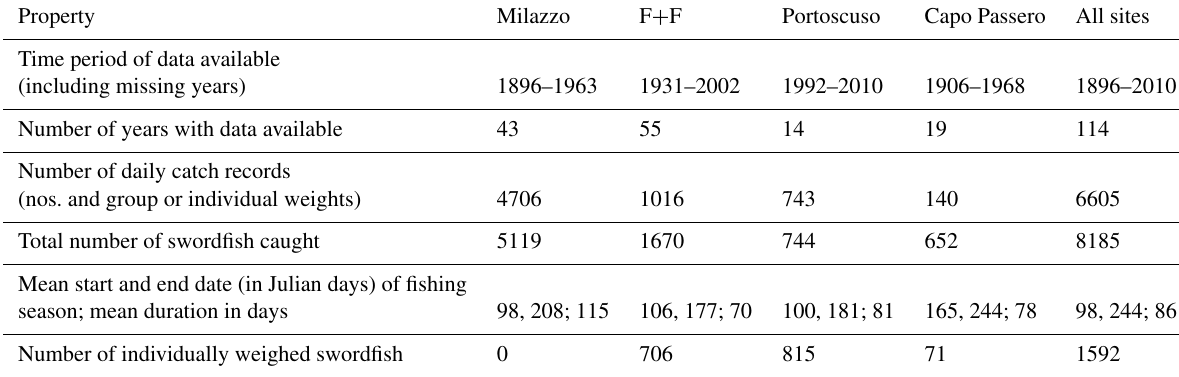
Table 2. Summary of swordfish bycatch and size data recovered from four bluefin traps in Italy. Property Milazzo F + F Portoscuso Capo Passero All sites Time period of data available Number of years with data